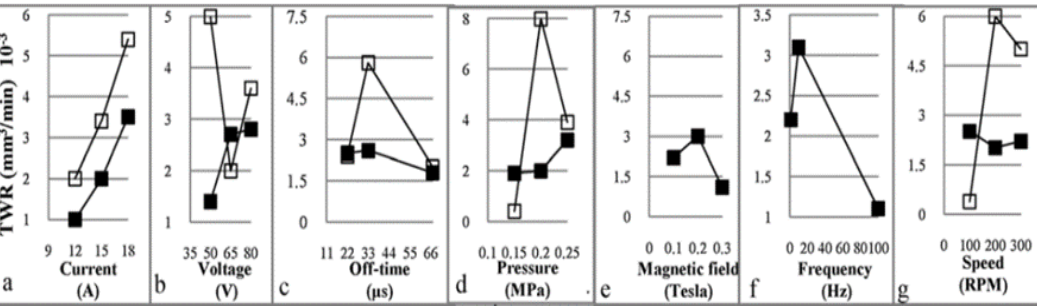
Figure 25. Comparative parametric plots for the TWR in MFA dry EDM and WMFA dry EDM [136].